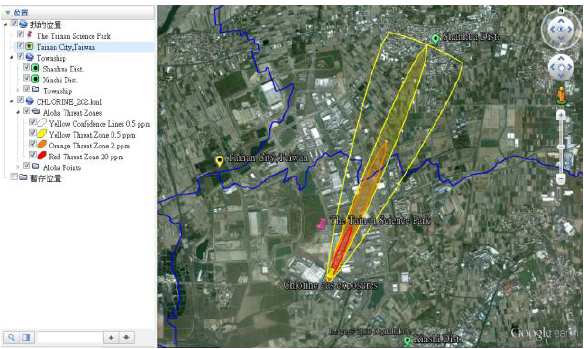
Figure 5. The threat zone of Chlorine gas exposures we demonstrate